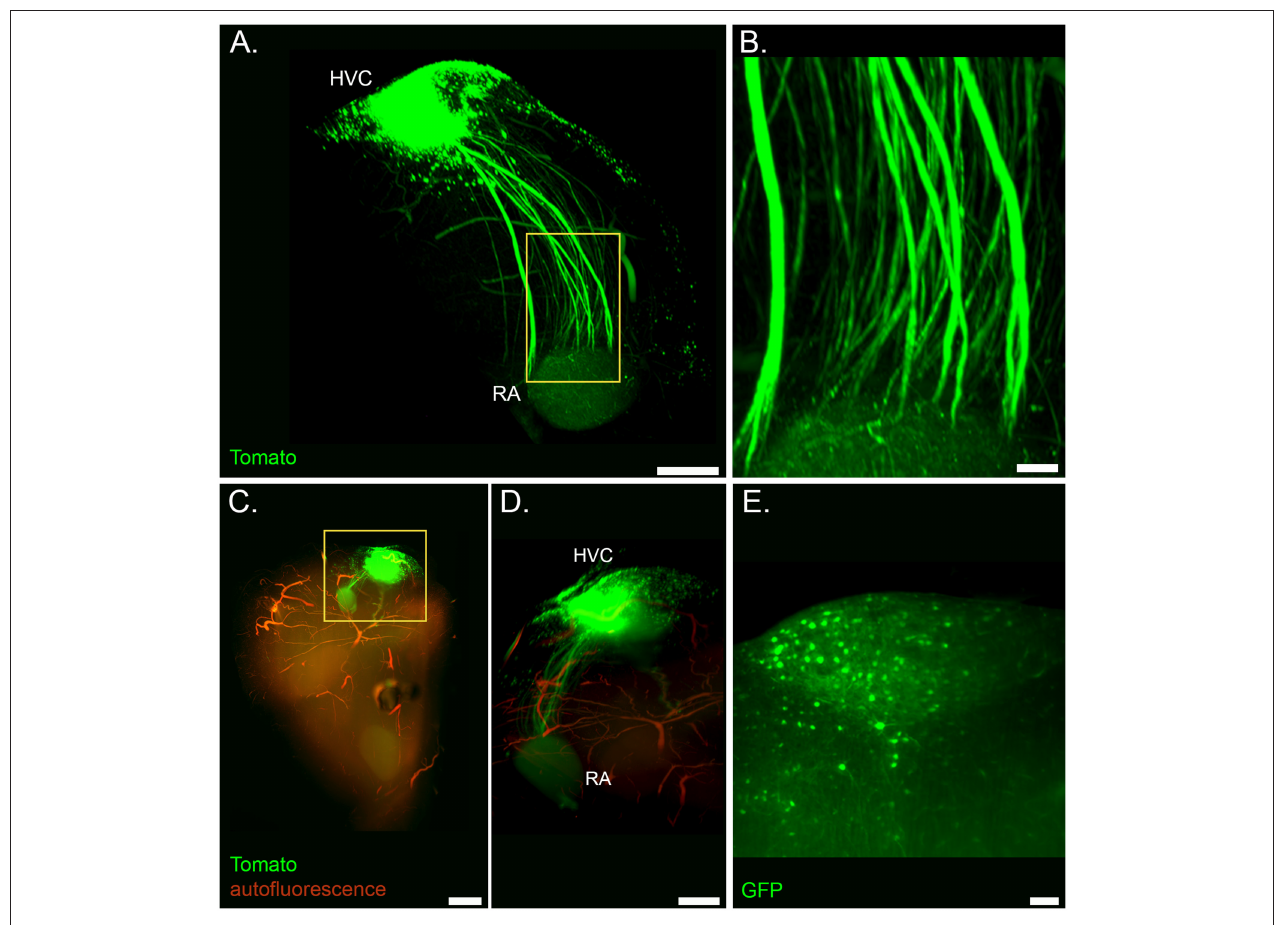
FIGURE 2 | Light sheet microscopy of the cleared song system. (A) Volume rendering of the HVC-RA projection from a sample of a lentivirus injected bird (Ultra Microscope II, 1x zoom, frontal view). (B) Detail of axonal tracts from highlighted region in (A) . (C) Volume rendering of a whole forebrain hemisphere showing the labeled HVC-RA projection with overlaid autofluorescent signal from vasculature (same tissue sample as in (A) ; dorsal view, top is caudal, bottom is frontal; mesoSPIM, 1.6x zoom) (D) Zoom into the highlighted region in (C) , showing the HVC-RA projection in more detail. (E) Optical section showing labeled cells in